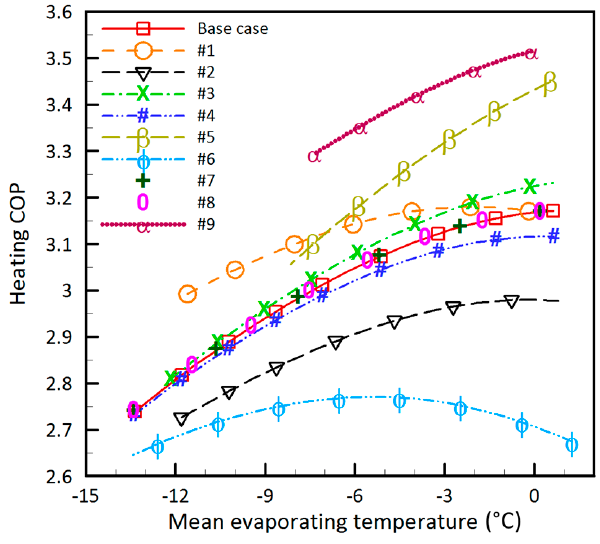
Figure 6. Coefficient of performance ( COP heating ).